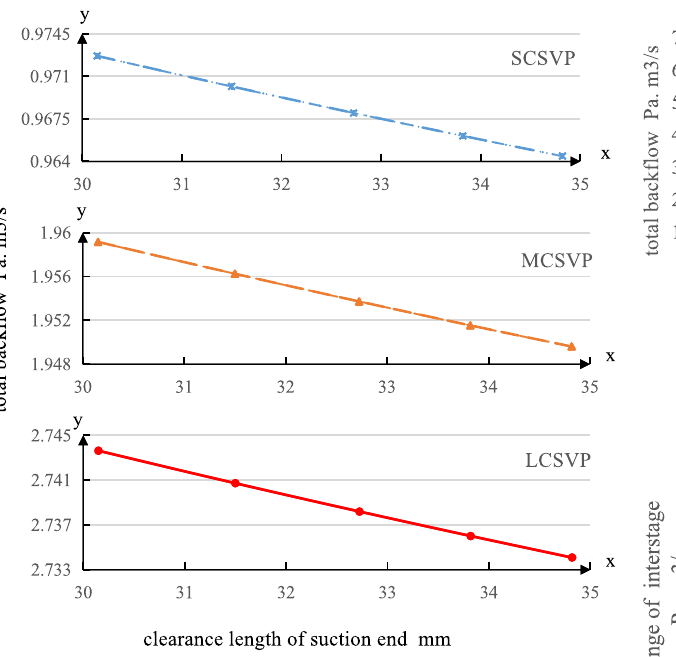
Fig. 17. Effects of clearance length on total back fl ow.